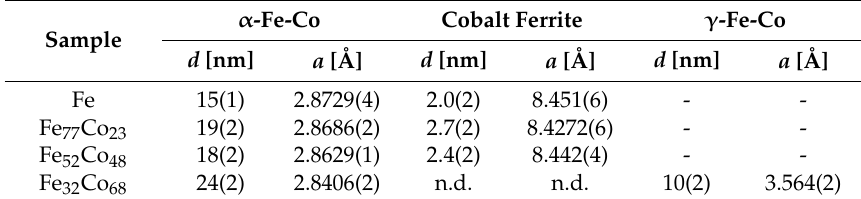
Table 5. Crystallite size d and lattice parameter a of the three crystalline phases identified by XRD in Fe-Co NPs. The FCC γ -phase is only observed at the highest Co